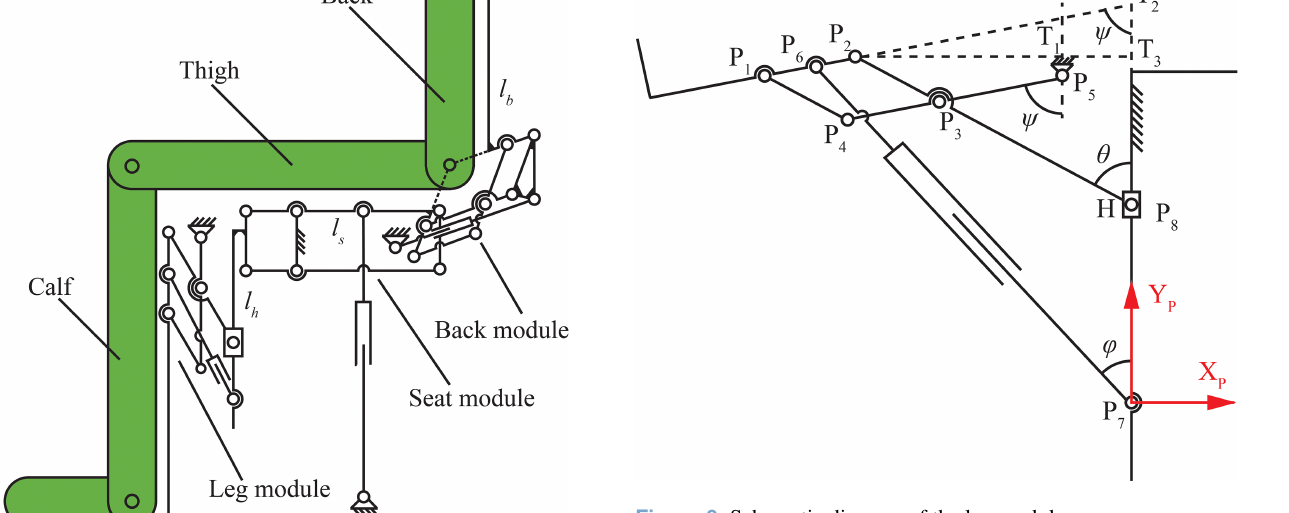
Figure 9. Schematic diagram of the leg